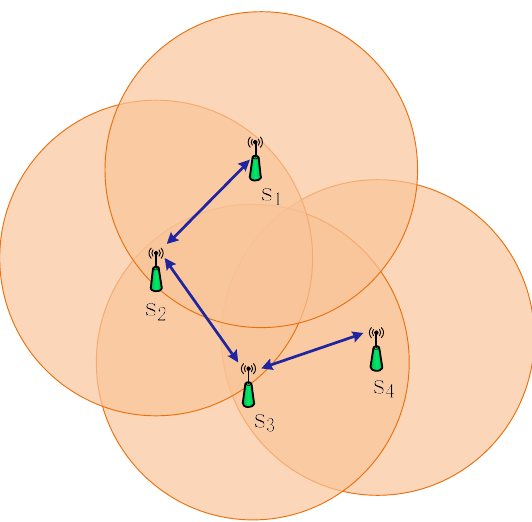
Figure 1. Communication network. s i represents the number of the sensor. The dotted line denotes the communication range of the sensor. The blue arrow represents the communication between the sensors.